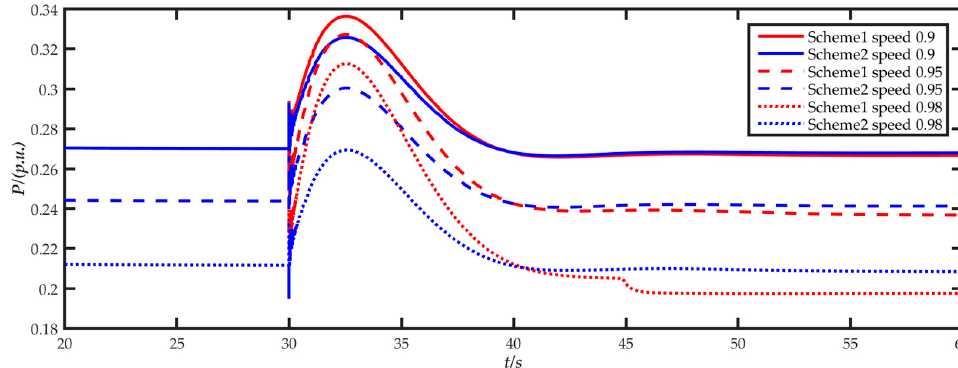
Figure 12. Power change in wind turbines in the medium-wind speed zone.